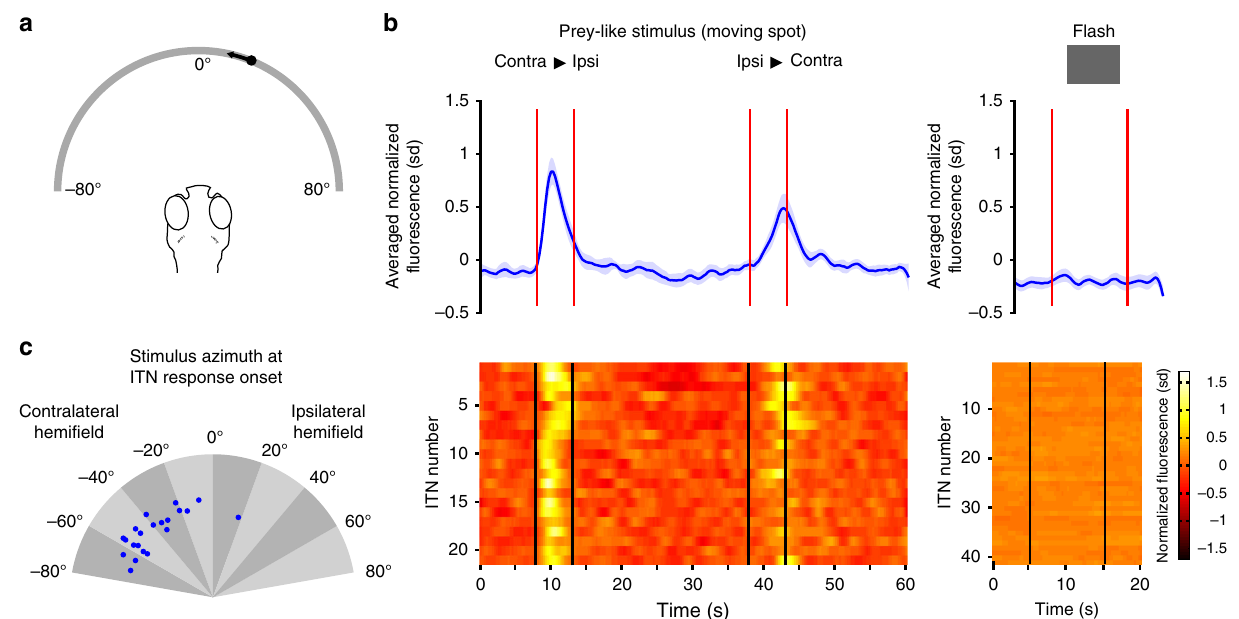
Fig. 4 ITNs display visual sensory responses to prey-like moving target stimuli. a Schema of the virtual hunting assay. 5 – 6 dpf ITN Gal4, UAS:GCaMP3 larvae were tethered in agarose with their eyes free to move. Small moving spots (size: 5°, speed: 30° s − 1 ) moving horizontally from right to left or vice versa were projected on a curved screen covering ~160° of visual space. At the same time, a 2-photon microscope was used to record fl uorescent calcium signals in ITNs in response to the visual stimuli as well as eye kinematics using an infrared imaging camera. b ITN cell bodies showed strong Ca-transient modulations in response to moving spots (stimulus intervals indicated by the red/black vertical lines, n = 21 ITNs from fi ve larvae) whereas ITNs did not respond to fl ashes ( n = 41 ITNs from three larvae). Traces show mean normalized fl uorescence intensities with 95% con fi dence intervals. Source data are provided as Source Data File. c Azimuth of moving spots at the onset of the response of each ITN to visual prey-like stimuli. ITNs collectively respond to moving spots spanning almost the whole contralateral visual hemi fi eld ( n = 21 ITNs from fi ve larvae). Source data are provided as Source Data